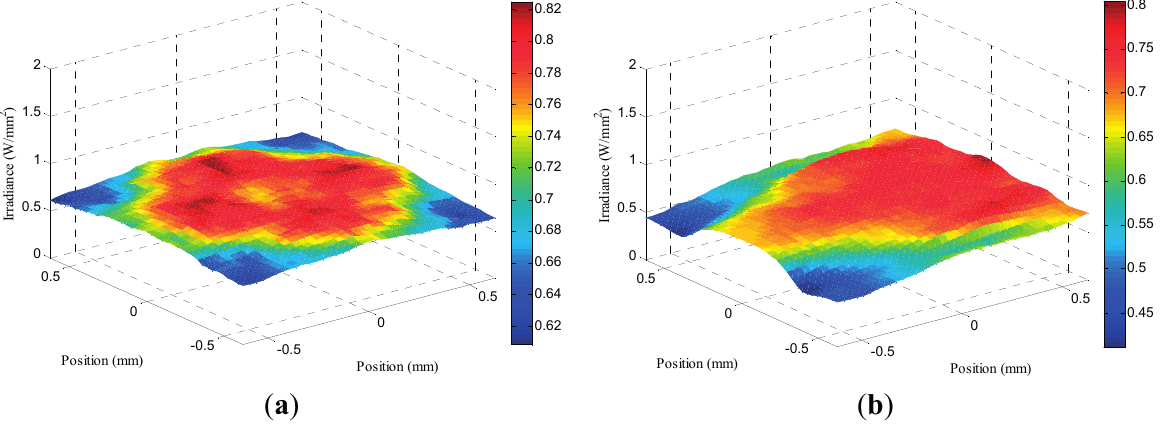
Figure 17. Irradiance distribution on the receiver for the Fresnel lens with KFTS II-type SOE ( a ) under normal incidence; ( b ) incidence angle =